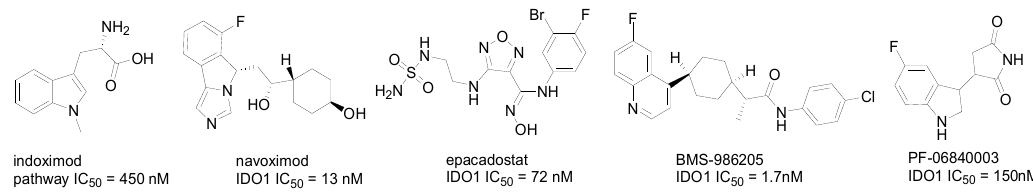
Figure 1. IDO1 inhibitors in clinical trials.